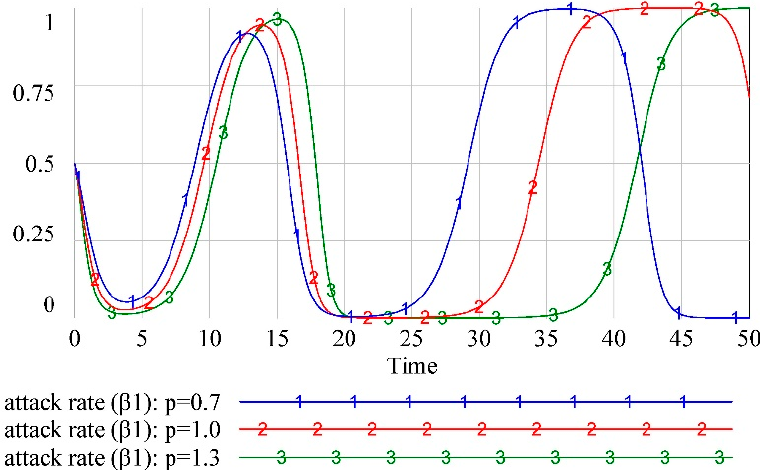
Figure 7. Effect of different penalty factors on attacker (1) in static penalty scheme.